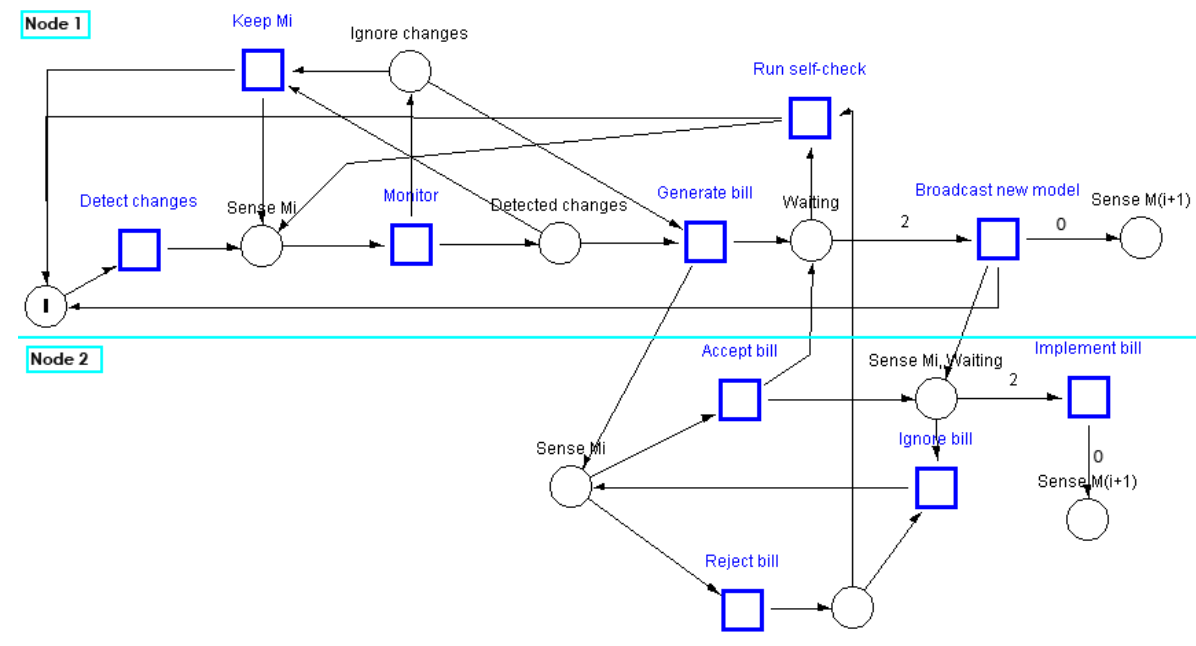
Figure 4. A Petri-net that models the